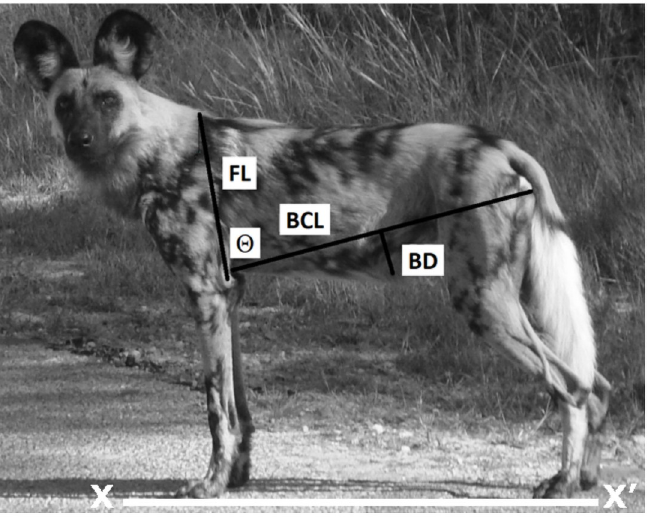
Fig 2. Example of suitable photograph of painted dog ( Lycaon pictus ) showing front leg (FL), belly chord length (BCL), and belly depth (BD) measurements and leg angle (denoted by Θ ) used to obtain belly score.